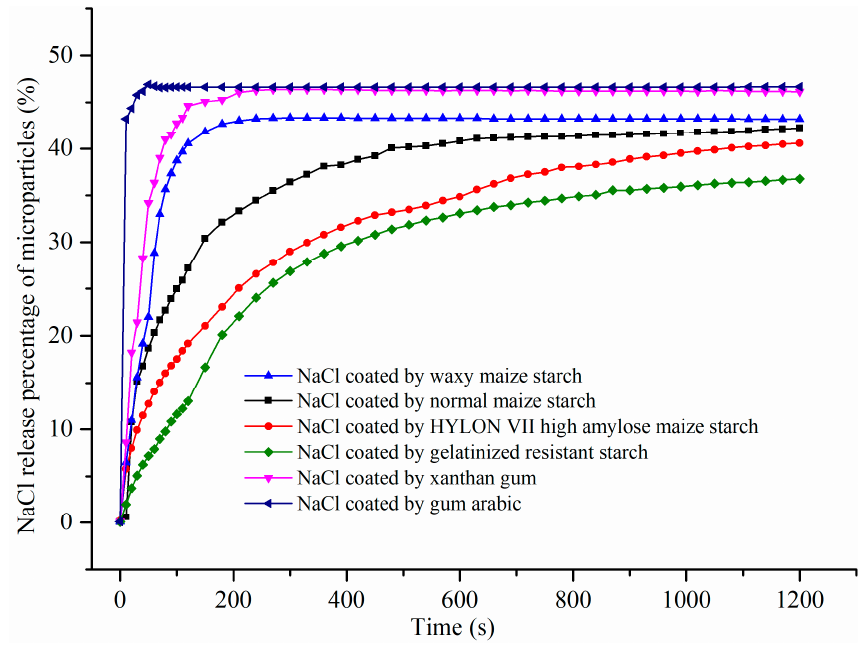
Figure 5. NaCl cumulative release profiles in deionized water.